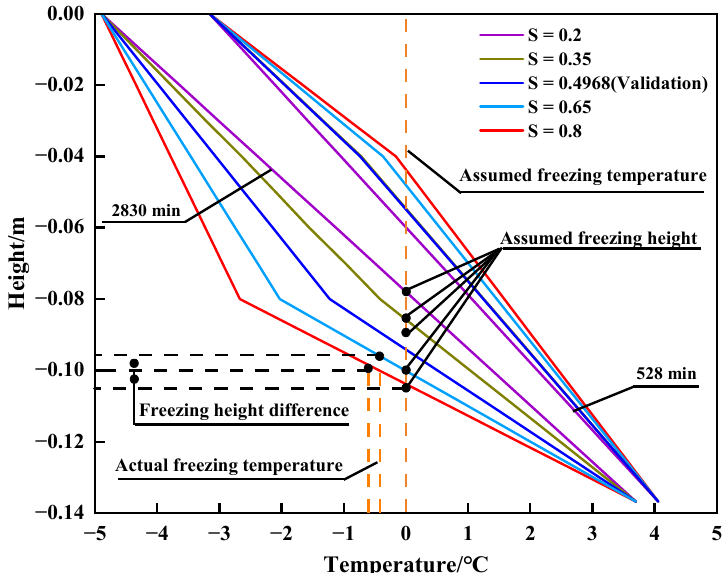
Figure 10. The effect of freezing